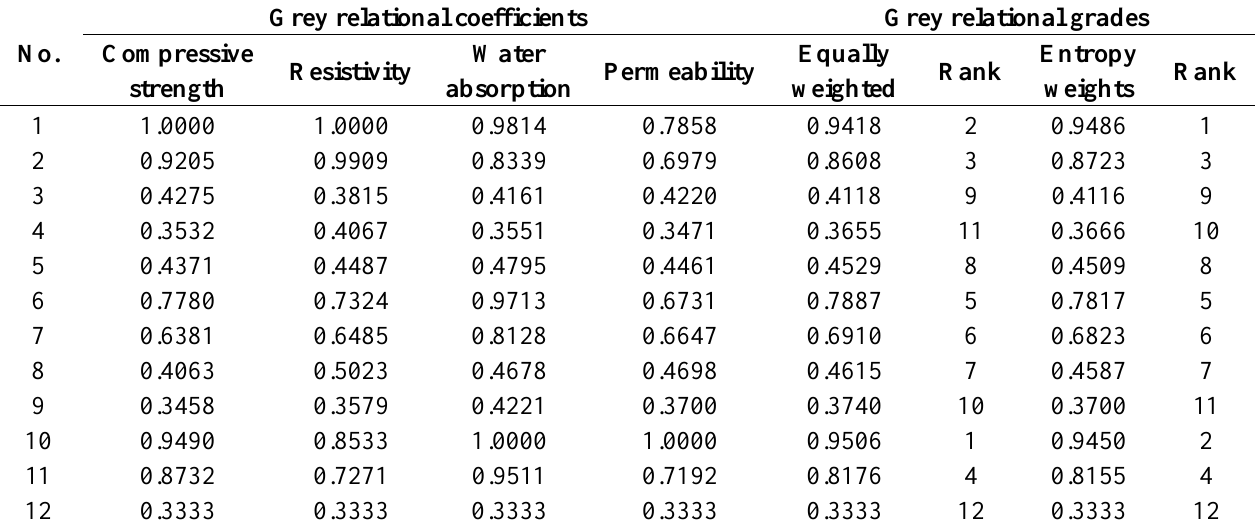
Table 7. Grey relational coefficients and grey relational